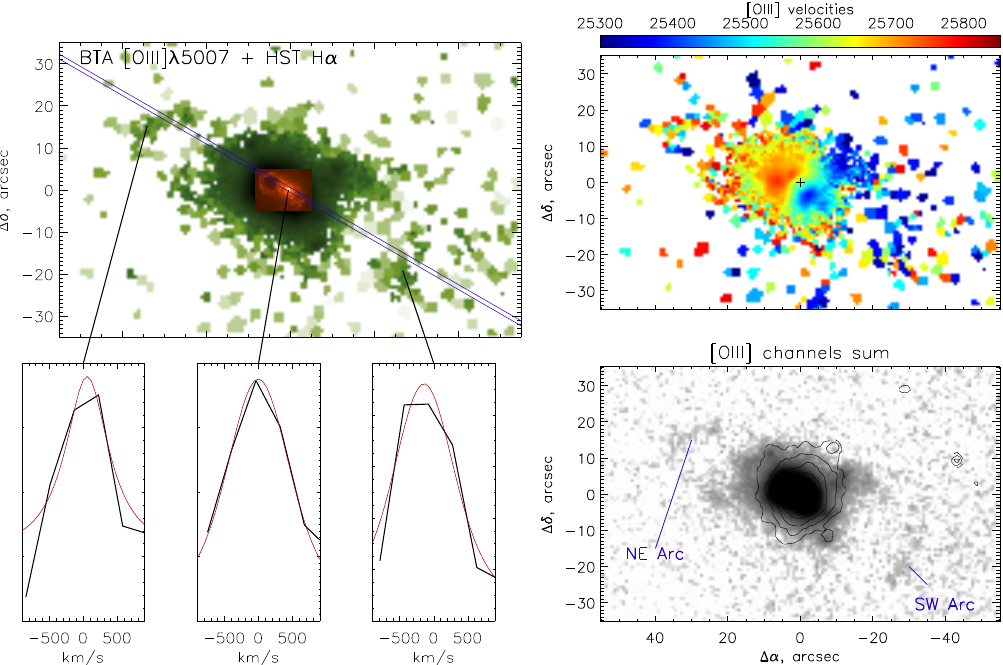
Figure 1. The left panel: the [O III ] emission map taken with FPI after Voronoi tessellation binning (the green scale) combined with ACS HST H α image [8] of the central bubble region (in the red scale). The purple lines mark the position of the spectrograph slit (1 (cid:48)(cid:48) in the width). The bottom plots show the emission-line profiles in the selected regions, the Voigt fitting is marked by the red. The right panels display the ionized gas velocity field (right top) and the sum of three channels centered at the emission line in the original 0.78 (cid:48)(cid:48) pixel scale with the isophotes of the image in the channel correspond to the stellar continuum. The most distance emission filaments are marked: the NE Arc (firstly mapped in Ref. [14]) and SW